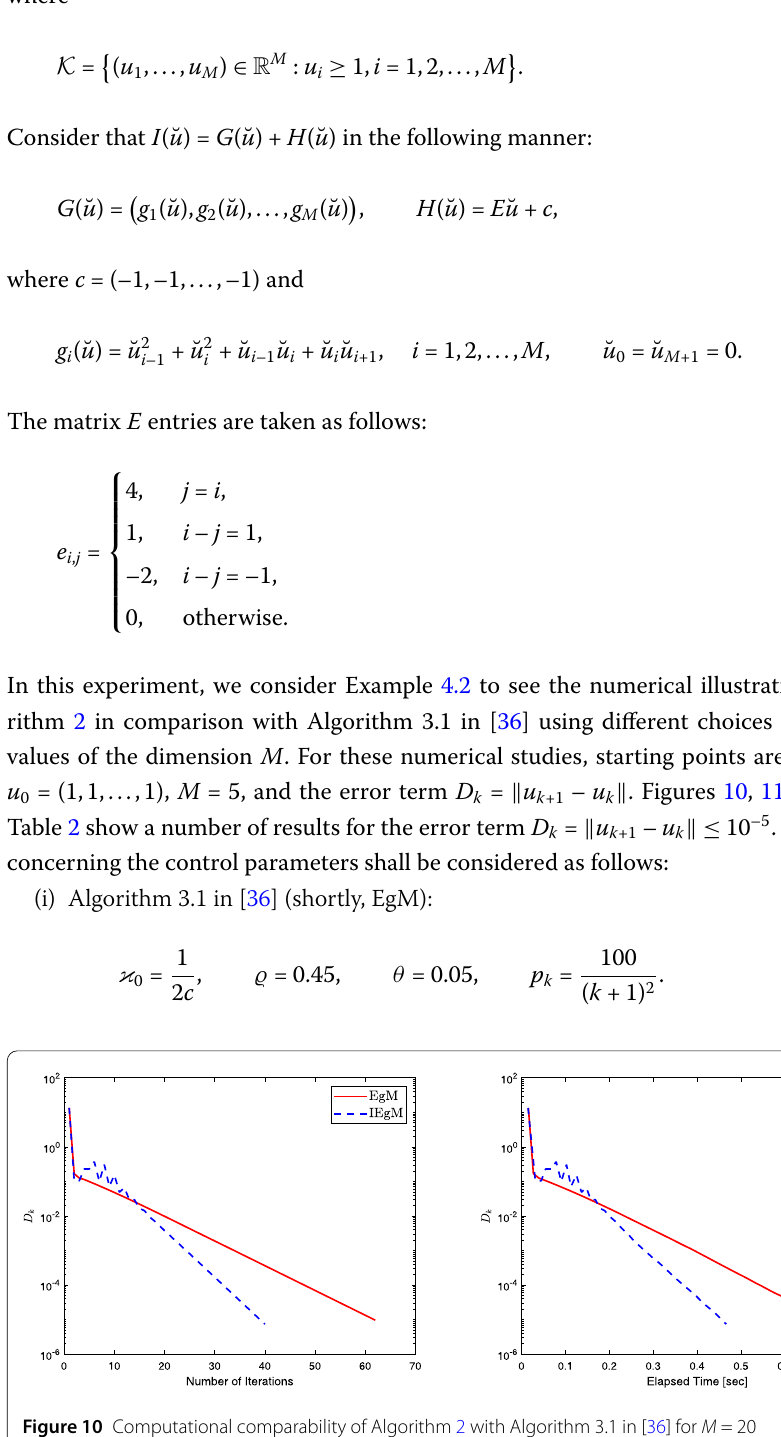
Figure 10 Computational comparability of Algorithm 2 with Algorithm 3.1 in [36] for M =